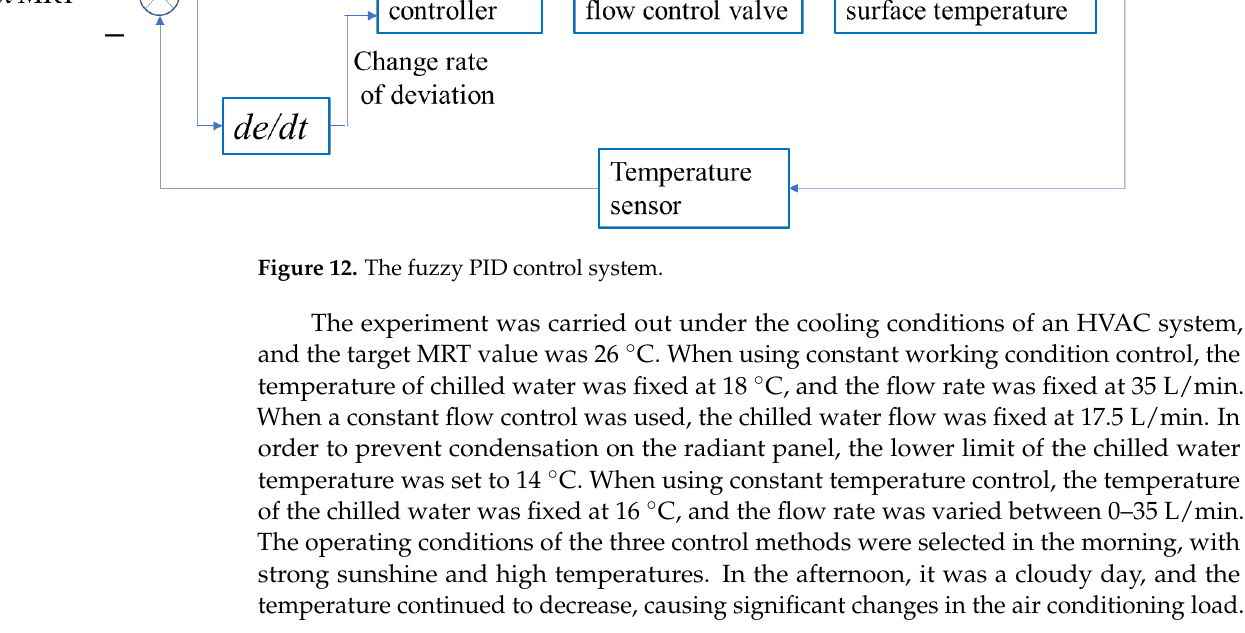
Figure 12. The fuzzy PID control system.